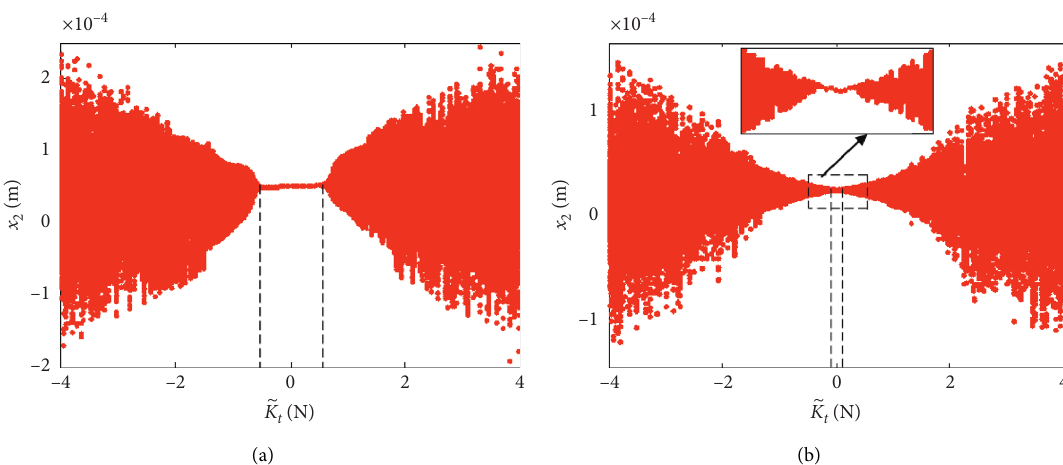
Figure 9: The system response versus feedback control gain 􏽥 K t ; the cloudy dots represent chaotic motion and line dots denote periodic motion. (a) Response of nonlinear system [17] and (b) response of the QZS system